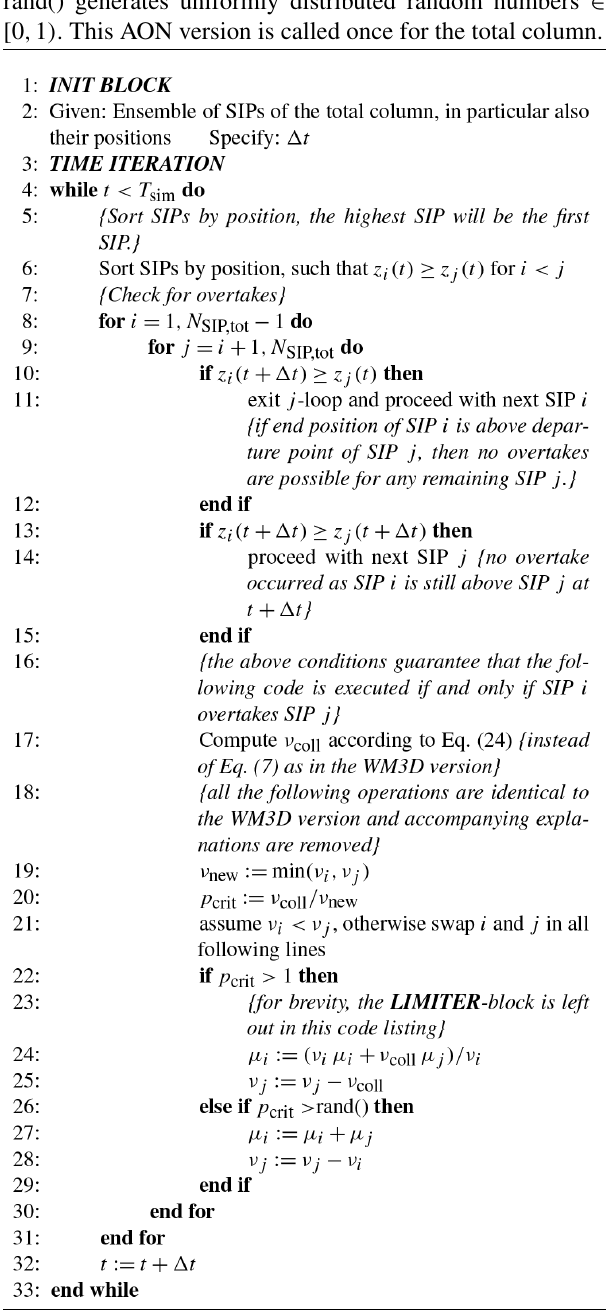
Algorithm 2 Pseudo-code of the AON-WM2D